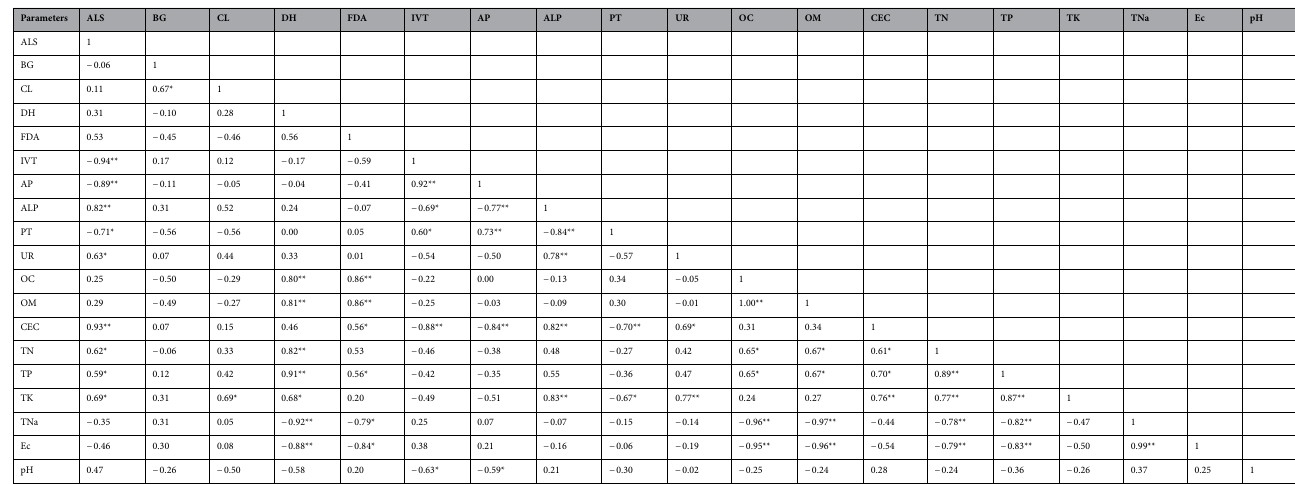
Table 2. Pearson’s correlation coefficients among soil chemical parameters and enzyme activities in rhizosphere soils of ‘RD 6’ rice collected from saline fields in Khon Kaen province, Thailand. Parameters; CL: cellulase, BG: β-glucosidase, IVT: invertase, PT: protease, UR: urease, AP: acid phosphatase, ALP: alkaline phosphatase, ALS: arylsulfatase, DH: dehydrogenase, FDA: fluorescein diacetate, OC: soil organic